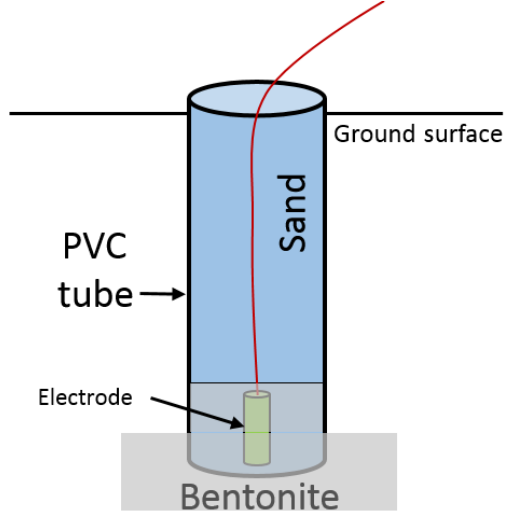
Figure 3. Schematic of electrode installation.